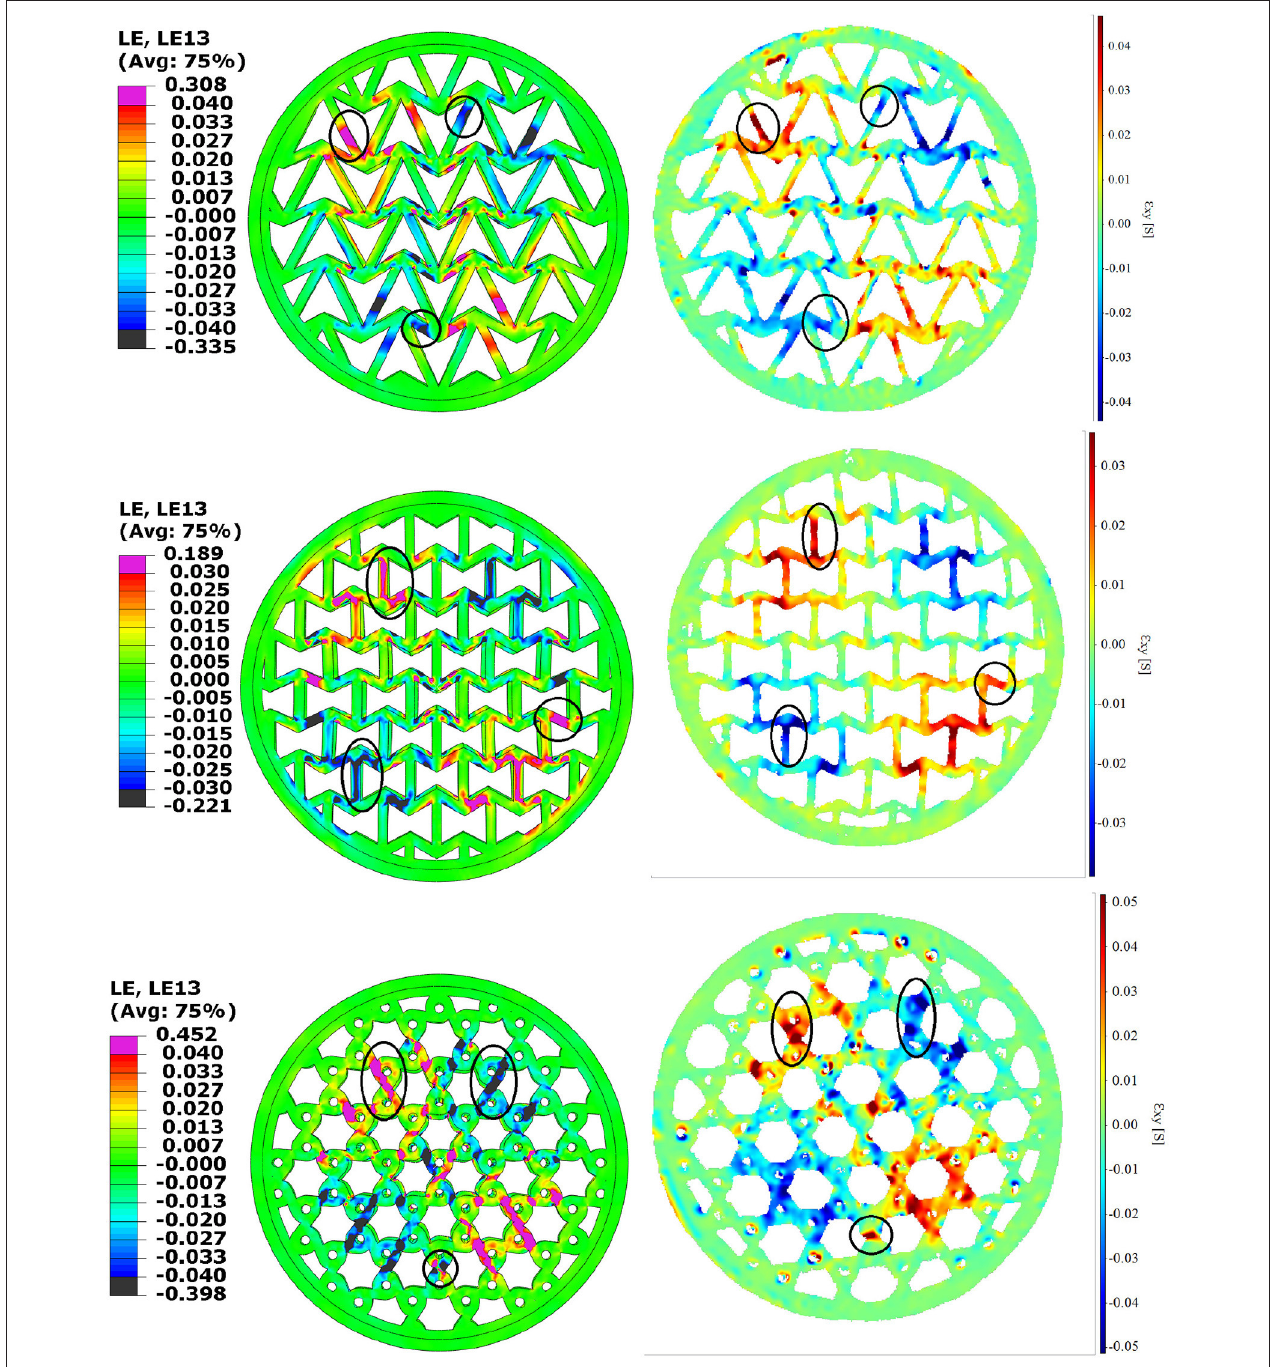
FIGURE 12 | FE (Left) vs. DIC (Right) ǫ 23 at buckling for 3 topologies: arrow-head in the top row, re-entrant in the middle row and tri-chiral in the bottom row.